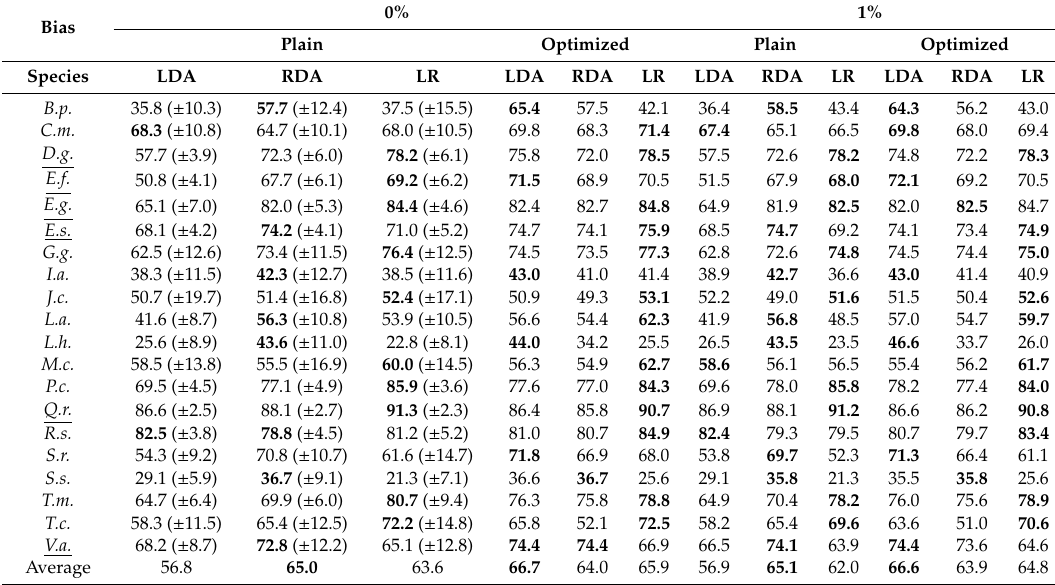
Table 3. Object level F-measure (and its standard deviation in brackets) of species binary classifiers trained with 1% mislabeling of the non-focal class. Plain and optimized indicate whether an optimization step (selecting a threshold probability value) was applied to maximize either the F-measure (0% contamination) or the Lee and Liu 2003 criterion (1% contamination). Standard deviation is given in Appendix B. The best prediction for each species and method is in